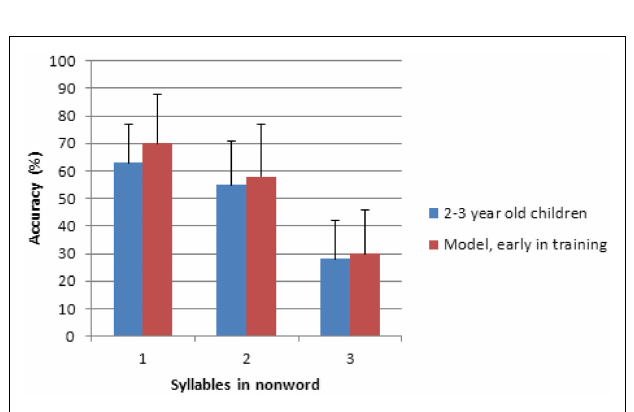
FIGURE 2 |Two- to three-year-old children’s non-word repetition performance together with the model’s performance early in its training. Error bars indicate standard